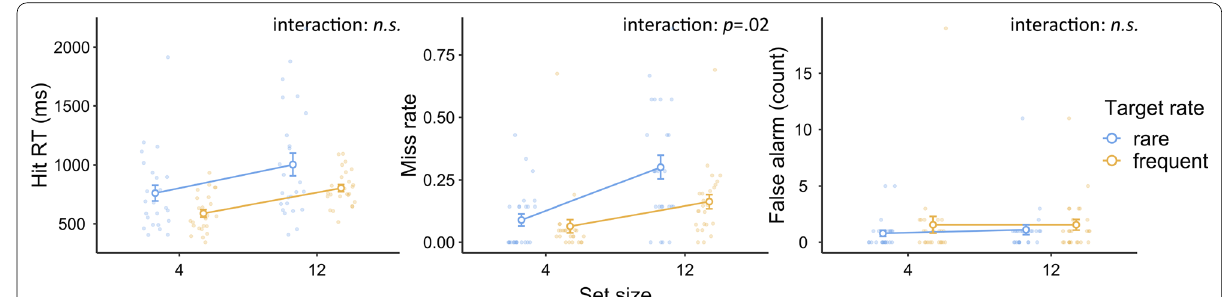
Fig. 10 Experiment 4 results: visual search. Note In Experiment 4, target-rate effects occurred in terms of hit RT and miss rates but not on false alarms. Target rate did not affect search efficiency on hit RT, but there was an apparent set-size effect on miss rate. We believe the latter reflected a floor effect only. Error bars represent 1 standard error of the ±